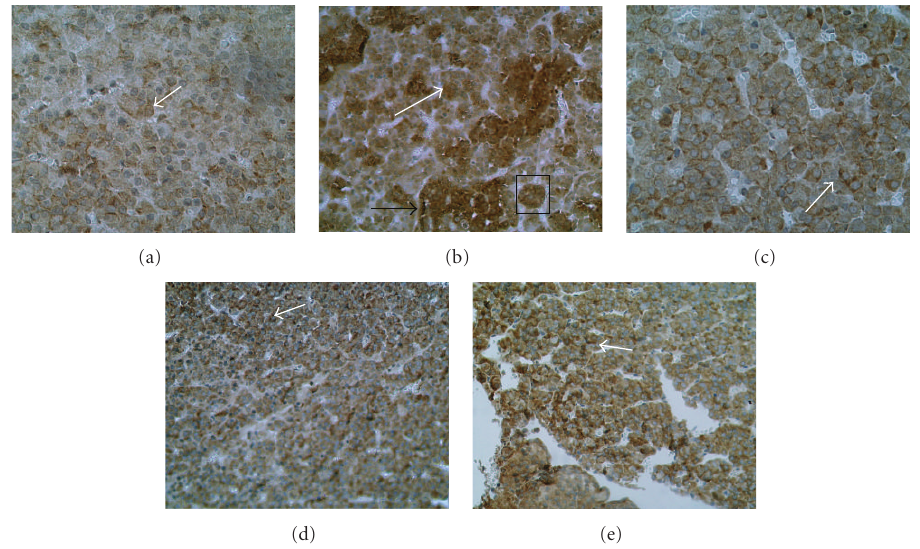
Figure 5: Immunohistochemical staining for vascular endothelial growth factor (VEGF) in anterior pituitary of rats; (a) control diethylstilboestrol- (DES-) untreated group, (b) control DES-treated group, (c) DES and AT1 blocker (losartan) cotreated group, (d) DES and AT2 blocker (PD12319) co-treated group, and (e) DES and angiotensin converting enzyme inhibitor (captopril) cotreated group. The white arrows indicate the single-VEGF-positive pituitary cell, the black arrow indicates the VEGF immunopositive blood vessel, within the black rectangular: the example isle of VEGF immunopositive cells in rat anterior pituitary.